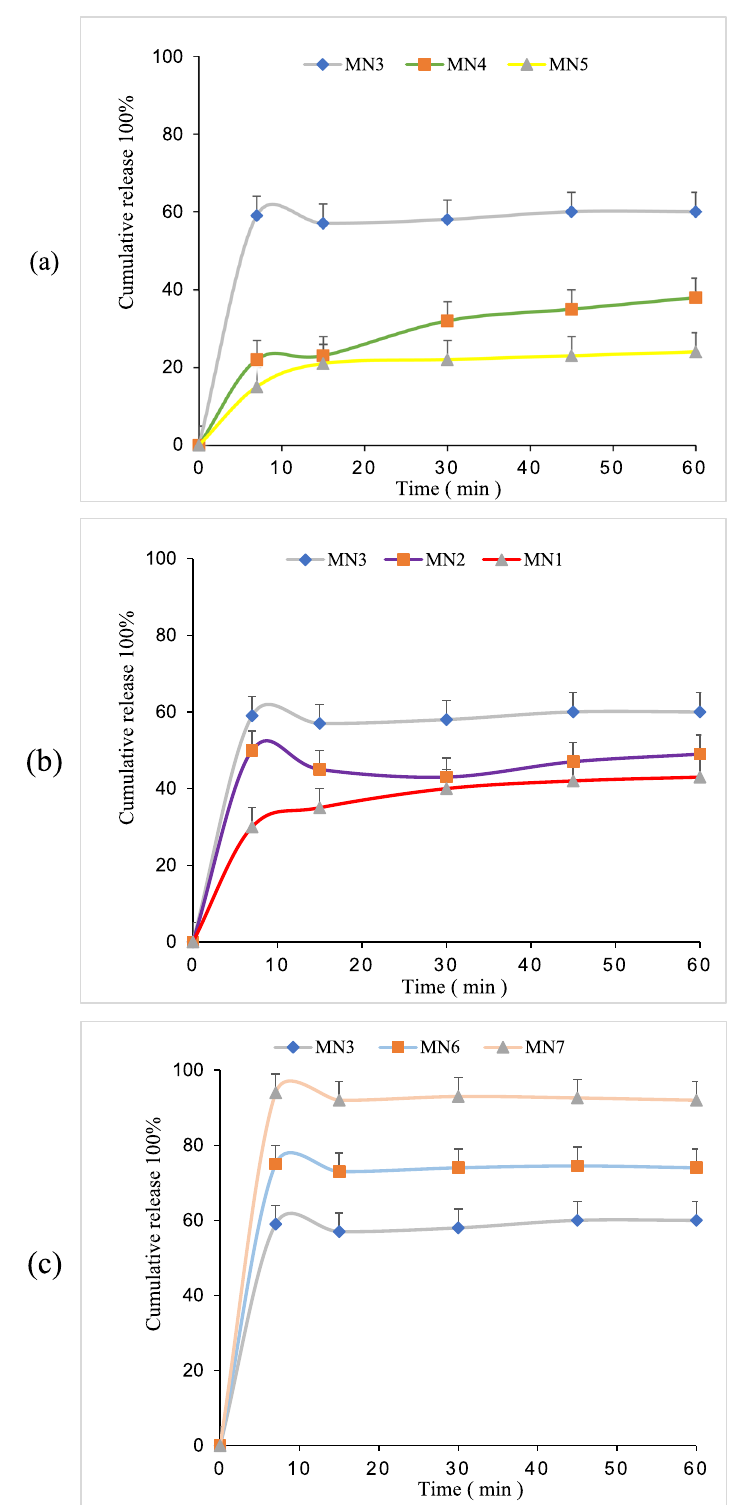
Fig. 8 Effect of a GTA, b polymer ratio, and c the amount of LidoHCl on in vitro release